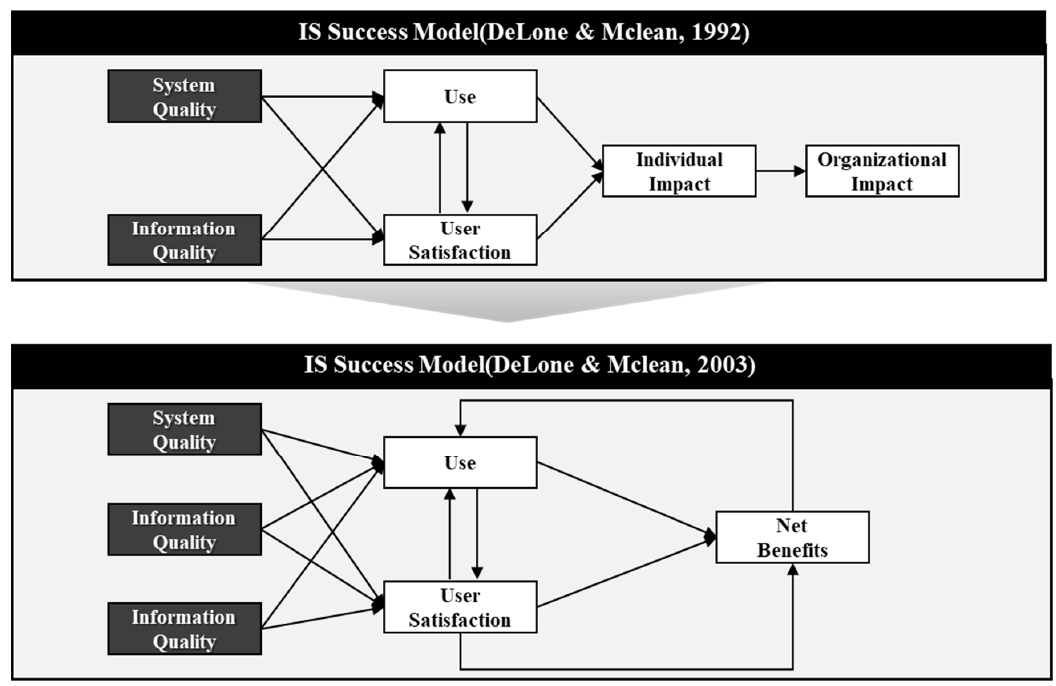
Figure 2. IS success model (1992, 2003).